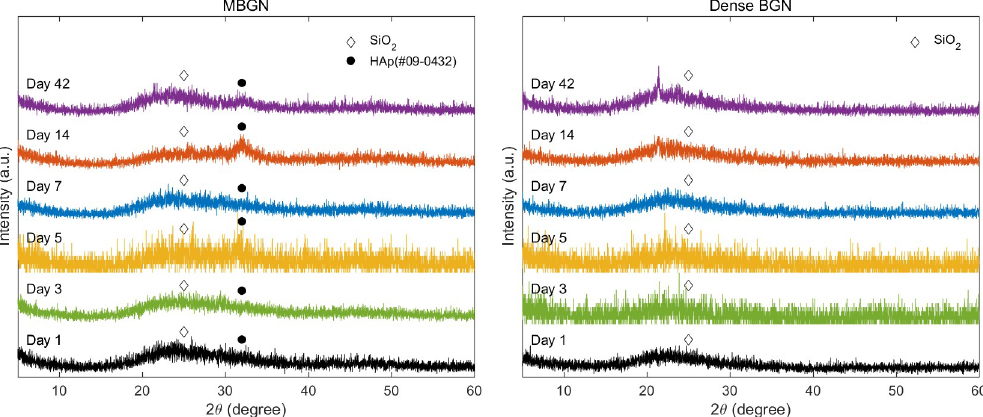
Fig 8. X-ray diffraction patterns of (a) MBGN and (b) Dense BGN at 1, 3, 5, 7, 14, 42 days after soaking in simulated body fluid (SBF) solution.